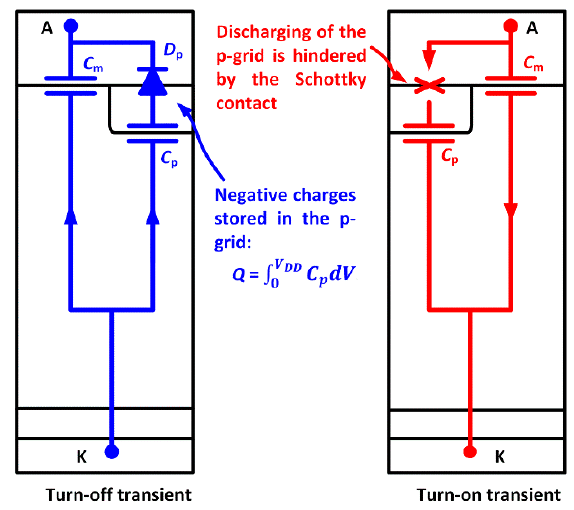
Figure 6. Illustration of the charge storing mechanism in the SiC JBS diode with Schottky contact to p-grid.